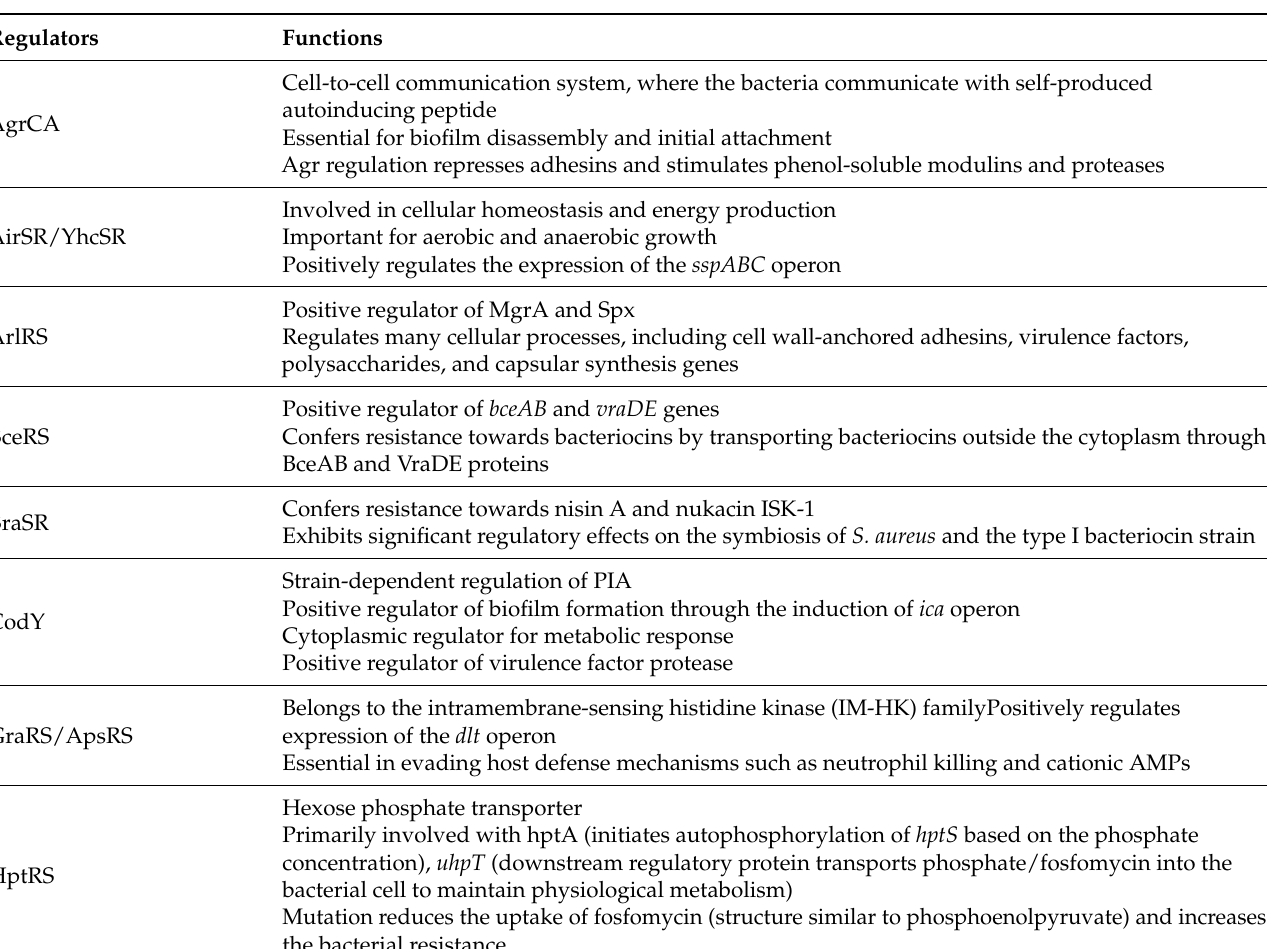
Figure 2. Illustration of the agr quorum sensing system in Staphylococcus aureus and RNAIII regulation of virulence factors. The precursor AIP is encoded by the agrD gene. AgrB is a transmembrane protein likely to be involved in the maturation and transport of the precursor AIP. AIP can bind to AgrC that, together with AgrA, form a TCS signaling system and increase agr activity. Table 2. Summary of the role of two-component systems and other regulatory genes involved in the virulence genes expression in Staphylococcus aureus